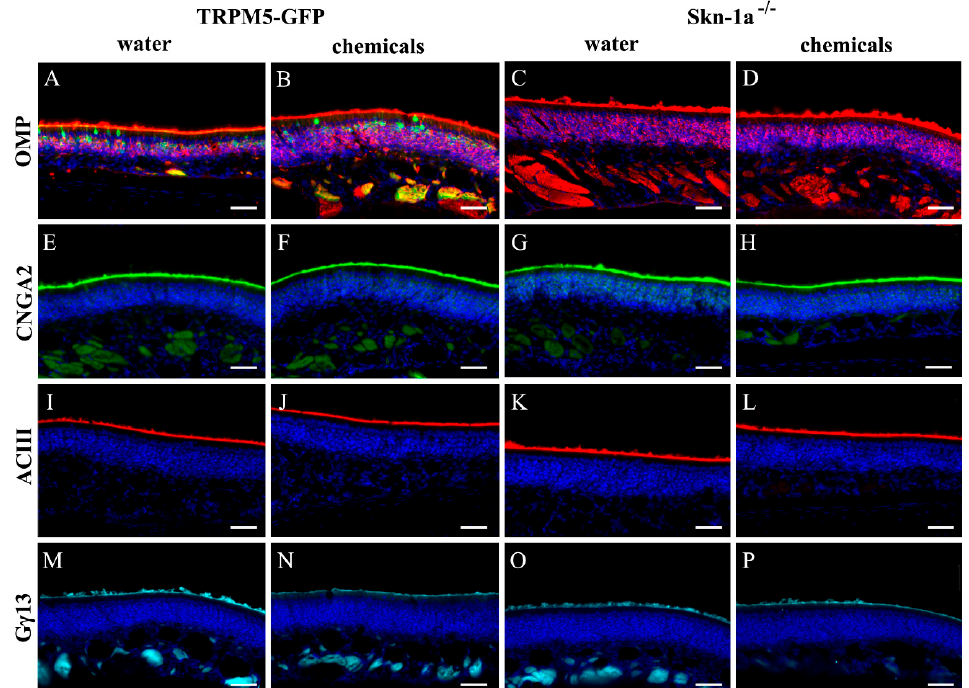
Figure 1. Immunolabeling of olfactory marker protein (OMP) and signaling proteins in TRPM5-GFP and Skn-1a − / − mice. ( A – D ) Immunolabel of OMP (red) in mature OSNs. TRPM5 expression in